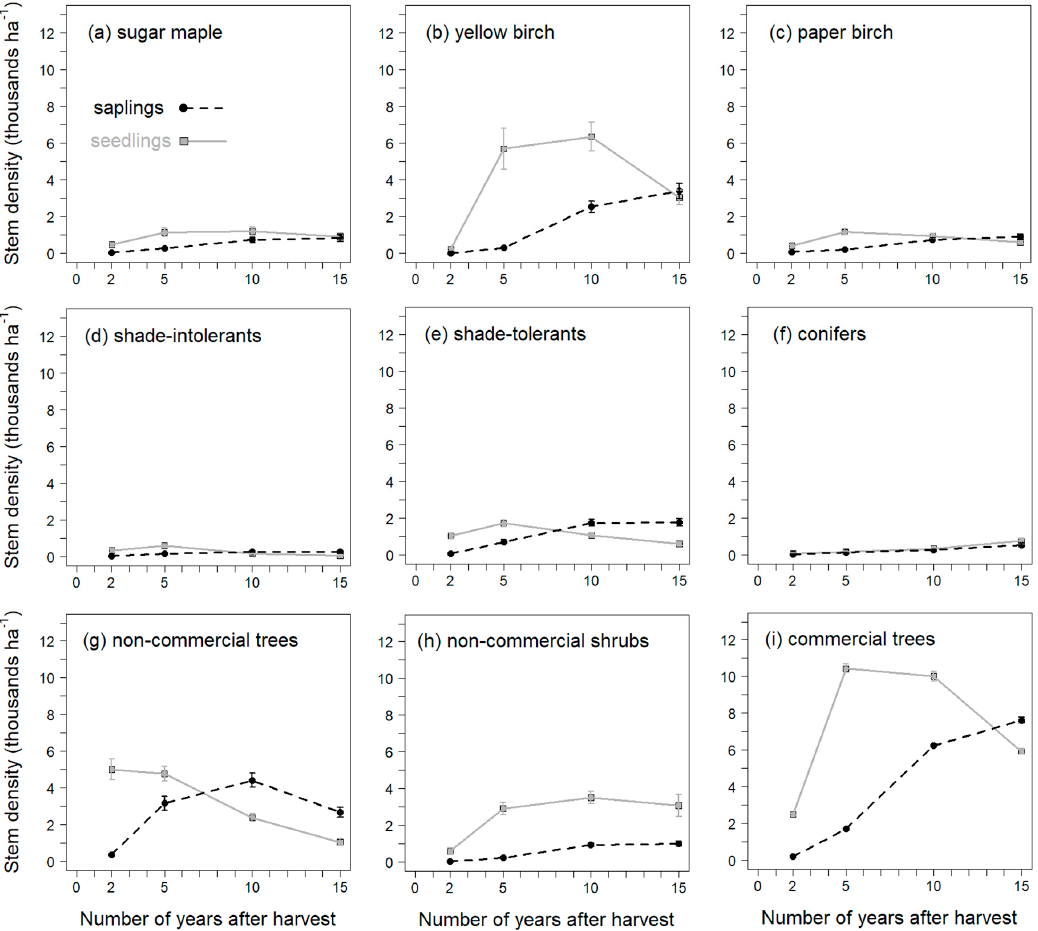
Figure 4. Stem density over time, per developmental stage (seedlings ≥ 1 m in height, saplings) and per species or species pool (see Table 1). Data are cluster means (groups and patches combined) averaged per year and per species or species pool ( a – i ). Error bars are standard errors.